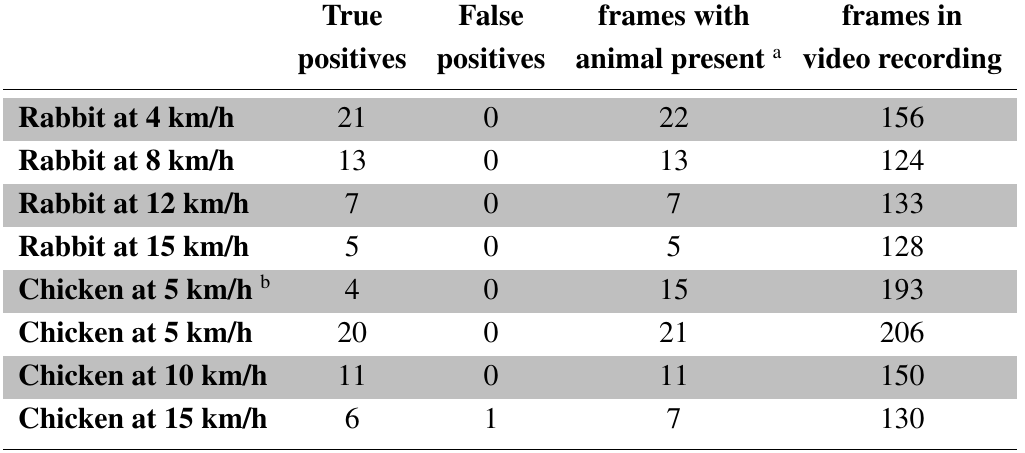
Table 1. Number of true and false positives for rabbits and chickens at different driving speeds. Number of Number of True False frames with frames in positives positives animal present a video